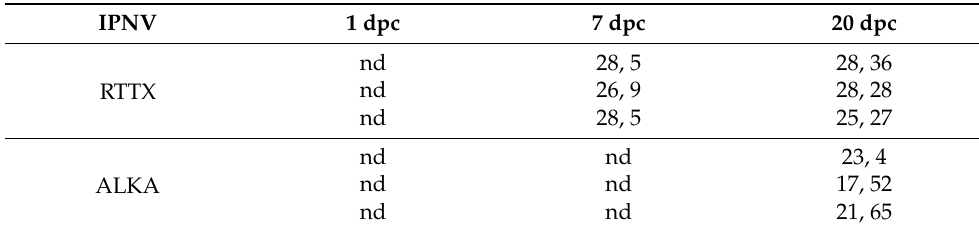
Table 1. Results of the analysis by RT-qPCR to detect the presence of IPNV and estimate the viral load in the samples of trout challenged with RTTX and ALKA at days 1, 7, and 20 post-challenge. The Ct values of the test directed to the VP1 virus polymerase gene are shown. More details of the assay can be found in Tapia et al.